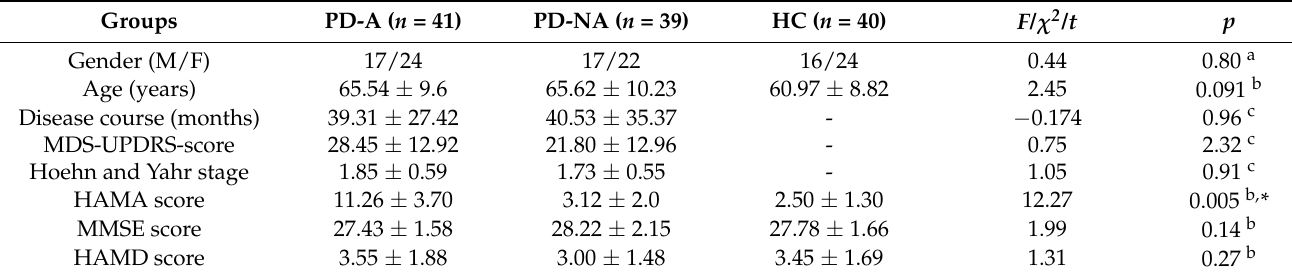
Table 1. Demographic and clinical characteristics of the